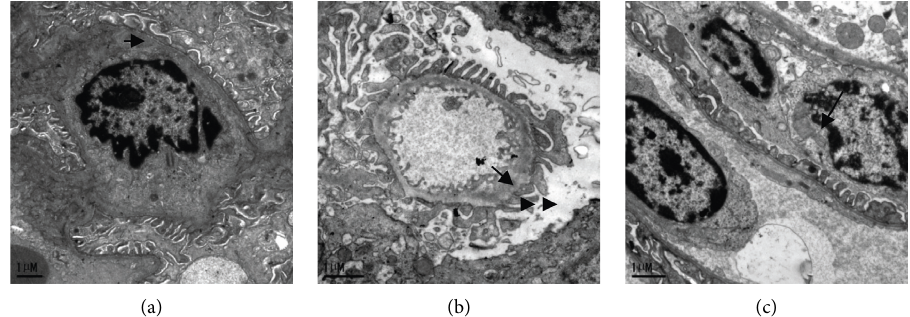
Figure 3: Low-dose group. (a) Podocyte fused obviously, podocyte flatted, decreased, podocyte width enlarged. (b) Flaky dense deposits, basement membrane thickened obviously. (c) Podocyte fused, flatted, decreased, podocyte width enlarged.